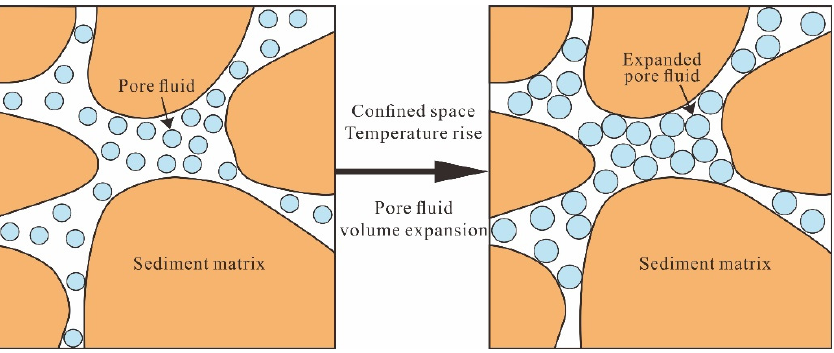
Figure 5. Schematic diagram for overpressure development by hydrothermal pressuring.